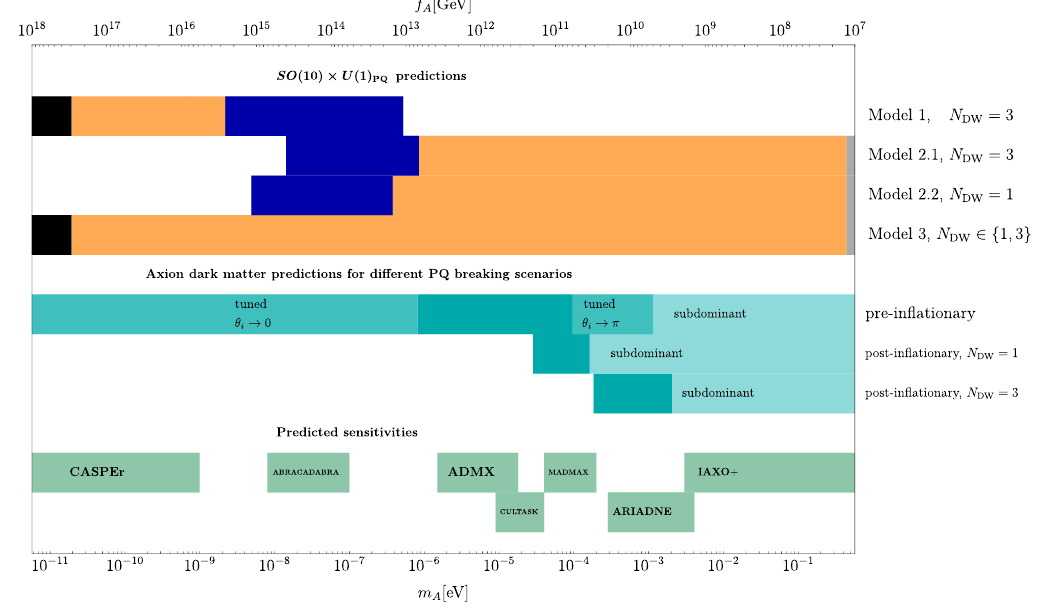
Figure 12 . Possible ranges of the axion mass and decay constant consistent with gauge coupling uni(cid:12)cation in our four models. Regions in black are excluded by constraints from black hole su- perradiance, regions in dark blue by proton stability constraints. Regions in gray are excluded by stellar cooling constraints from horizontal branch stars in globular clusters [65]. For comparison, we show also the mass regions preferred by axion dark matter (DM) (lines 5 to 7), cf. [68]. Here, the dark regions indicate the ranges where the axion can make up the main part of the observed DM, with the possibility of (cid:12)ne tuning the initial misalignment angle in the scenario where the PQ symmetry is broken before the end of in(cid:13)ation and not restored thereafter (pre-in(cid:13)ationary PQ symmetry breaking scenario). In the light regions, axions could still be DM, but not the dominant part. The remaining regions are not allowed - axions in this mass range would be overabundant. Note that the region in the N DW = 3 case has been derived under the assumption that the PQ ators are allowed at dimension 10 or higher [69]. In the last two lines the projected sensitivities